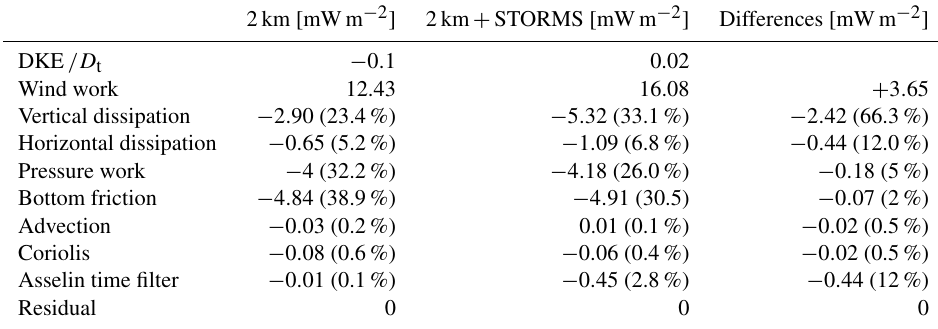
Table 4. Two-year mean KE balance (mWm − 2 ) averaged over the entire domain for the 2km reference experiments with (left) and without storm (right). The percentages give the fraction of total wind work that is balanced by the terms of the KE equation. The second series of numbers and percentages in the storm column refers to the storm − no storm differences. 2km [mWm − 2 ] 2km + STORMS [mWm − 2 ] − 0 .